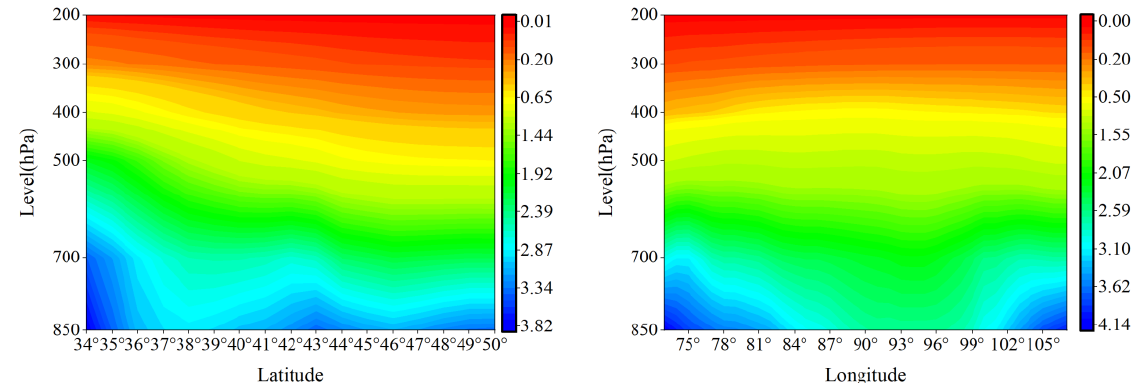
Figure 7. Vertical profiles of zonal and meridian average of specific humidity (g/kg) in different atmospheric levels during the period 1980–2018.